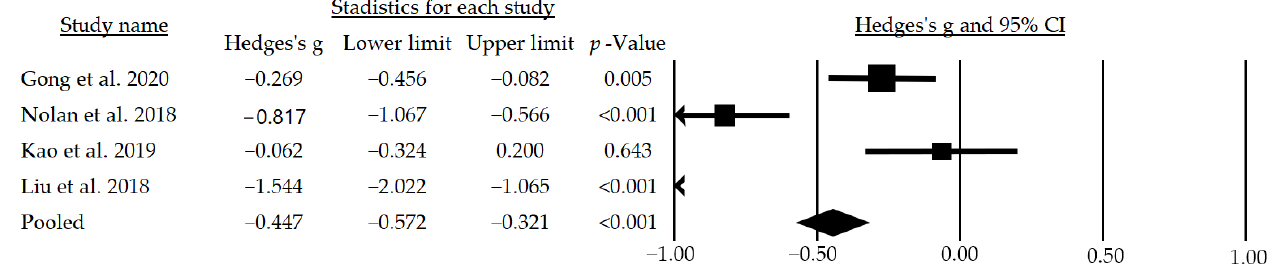
Figure 4. Effects of telemedicine on diastolic blood pressure in people with hypertension. The black box represents the point estimate for the respective study, while the size of the box represents the population size and the horizontal line is the 95% CI. The diamond-shaped figure represents the estimated point of the mean effect size. The arrow represents that the point estimate for this study is less than − 1.00